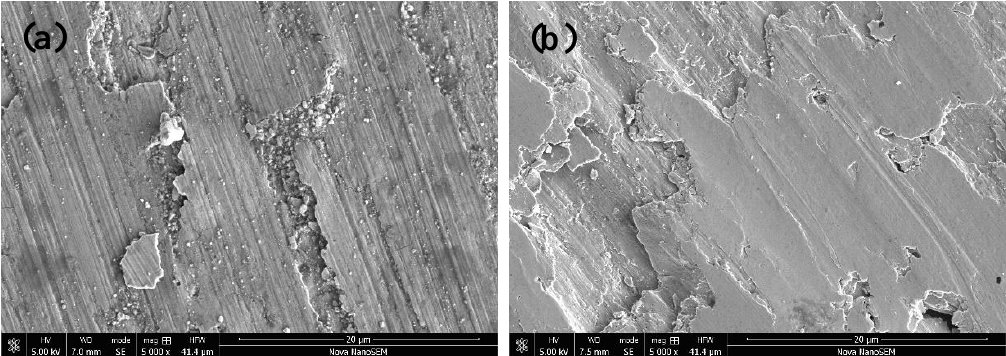
Figure 18. SEM morphologies of the worn surfaces of counter-body Al 2 O 3 balls: ( a ) coating 1; ( b ) coating 2.